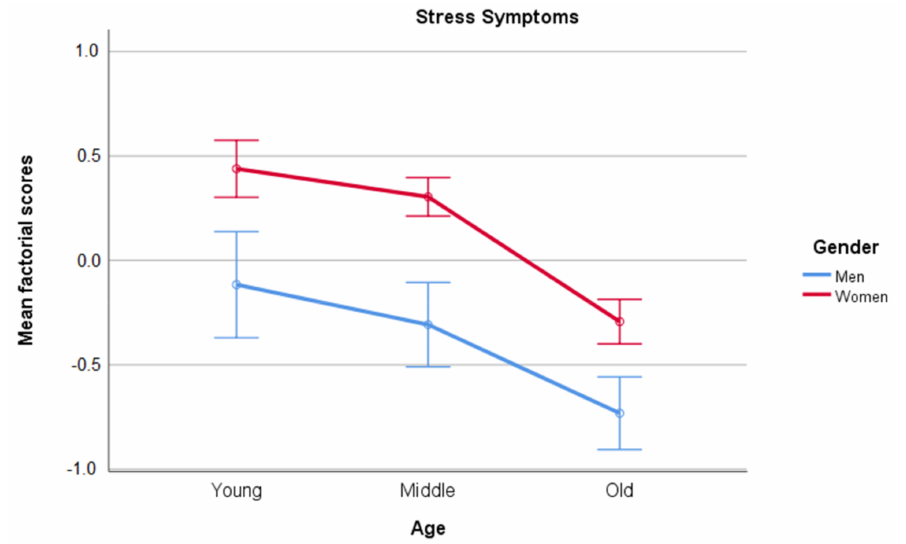
Figure 3. Mean scores and confidence interval (95%) for factor scores in Stress symptoms as a function of participants’ Gender and Age.